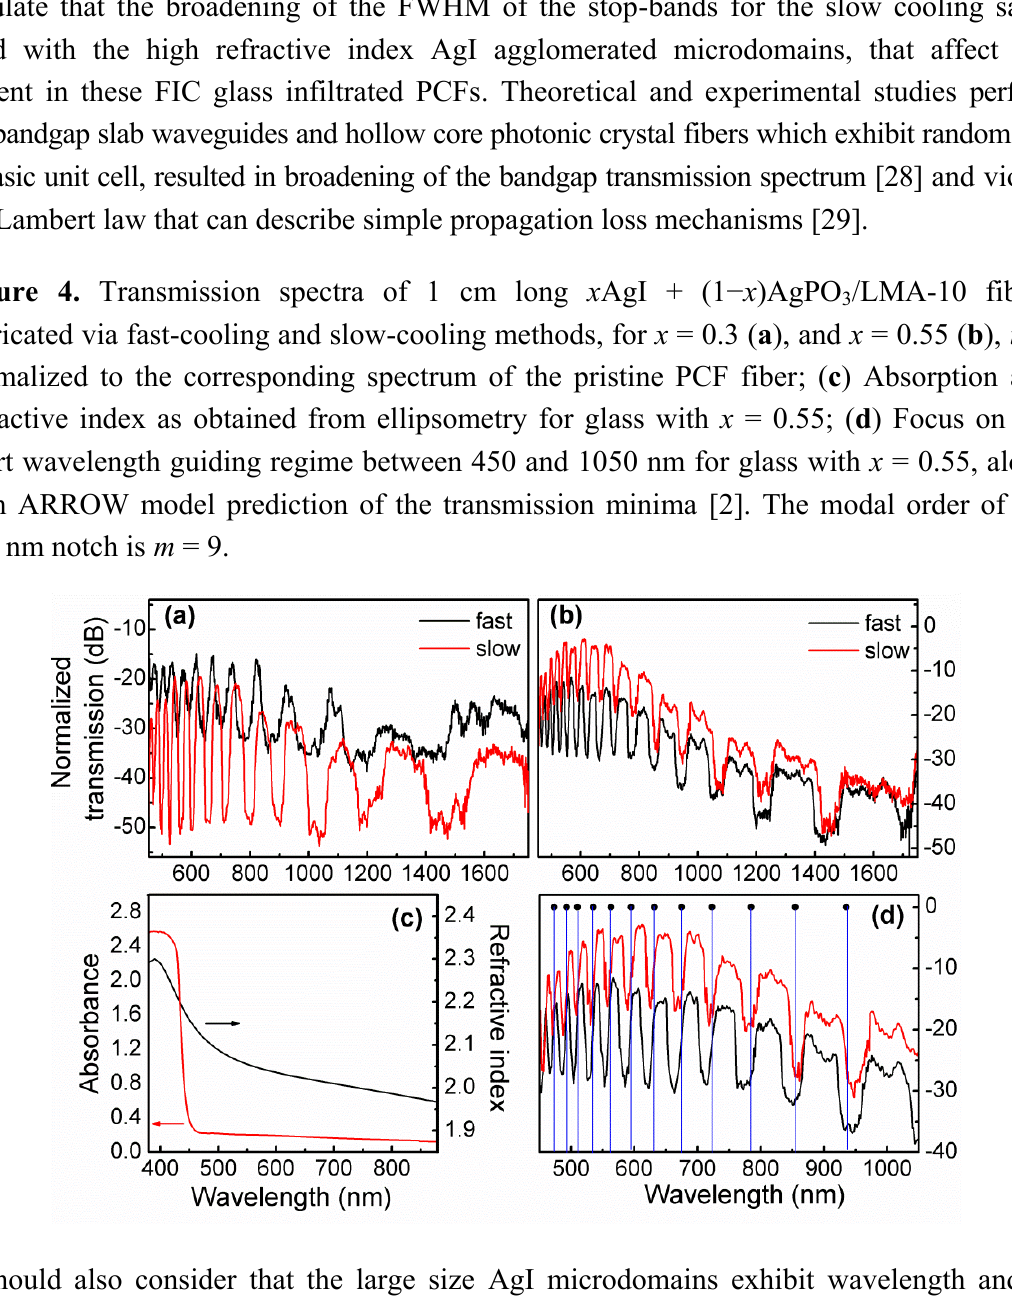
/LMA-10 fibers 3